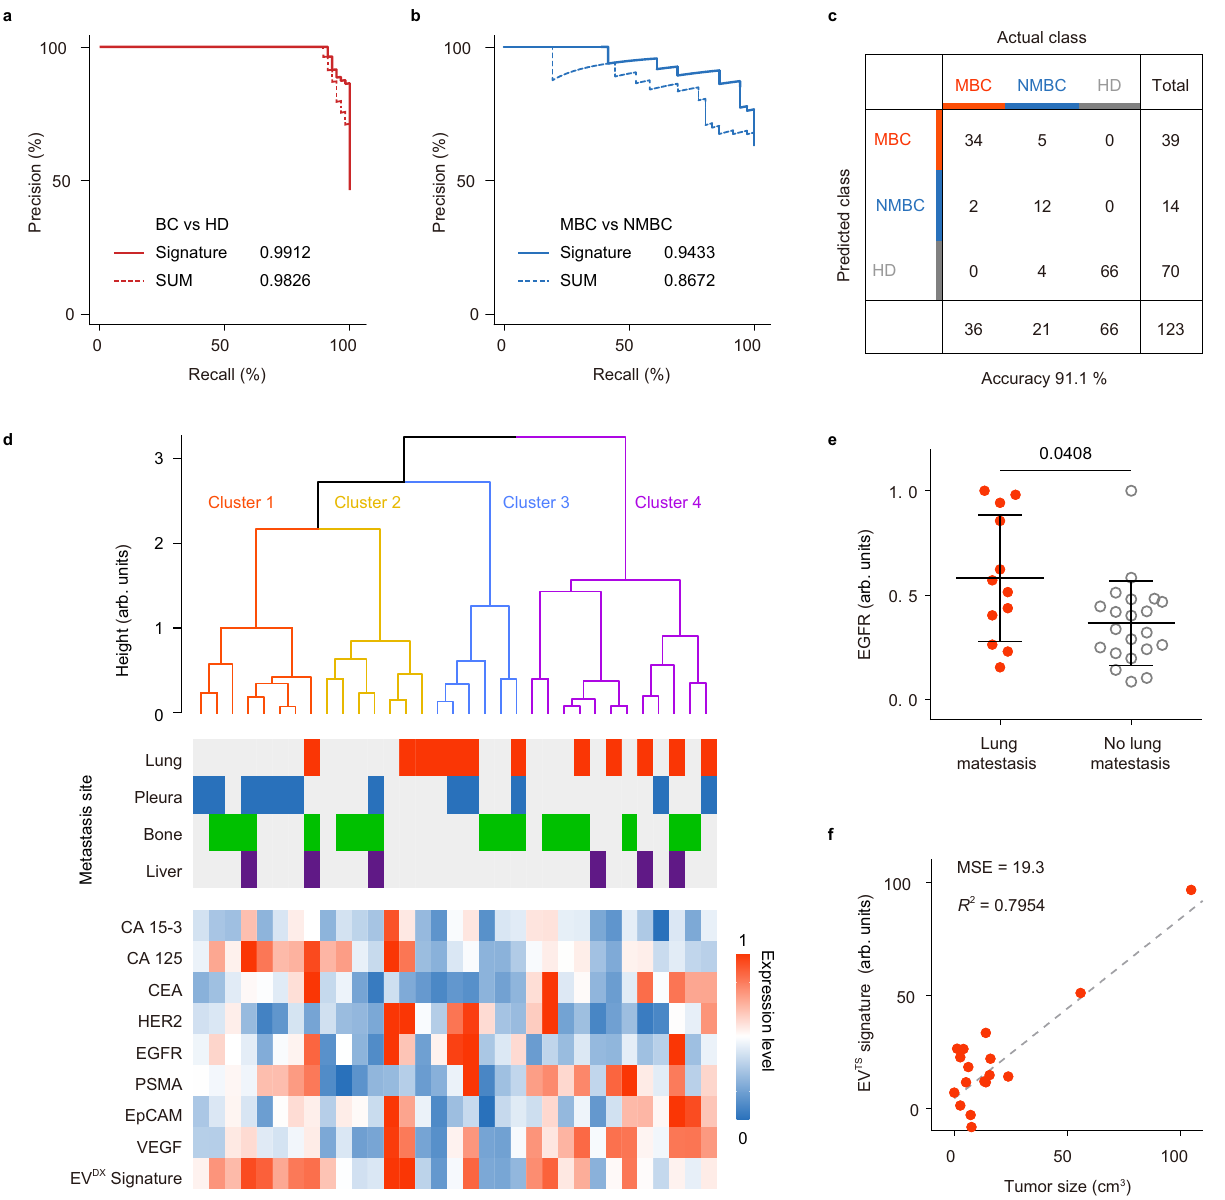
Fig. 3 EV DX signature for differentiation of MBC, NMBC, and HD. a , b PRC for the EV DX signature (a weighted sum of eight EV markers by LDA, solid lines) and SUM (unweighted sum of eight EV markers, dashed lines). c Confusion matrix showing an overall accuracy of 91.1% across MBC, NMBC, and HD. d Hierarchical clustering of individual EV protein markers and the EV DX signature showing no segregation according to metastasis sites of MBC patients. e Signi fi cant ( P = 0.0408) elevation of EGFR level on EVs from MBC patients with lung metastasis ( n = 12 patients, red dots), as compared to MBC patients without lung metastasis ( n = 21 patients, gray dots). Statistical difference was determined by a two-sided, nonparametric Mann – Whitney test. P value is indicated in the chart. f Concordance between tumor size and the EV TS signature identi fi ed using multivariate linear regression (MLR). Mean square errors (MSE) and R squared ( R 2 ) are indicated. Linear regression result is indicated by the dashed line. Error bars represent the mean ± s.d. in ( e ). Source data are provided as a Source Data fi